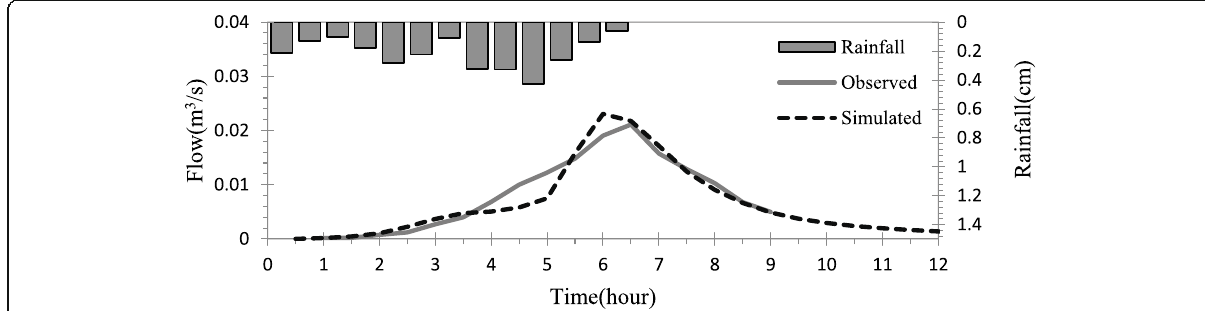
Fig. 6 Comparison of simulated and observed hydrographs derived from validation, run for the rainfall event of 26-03-2011